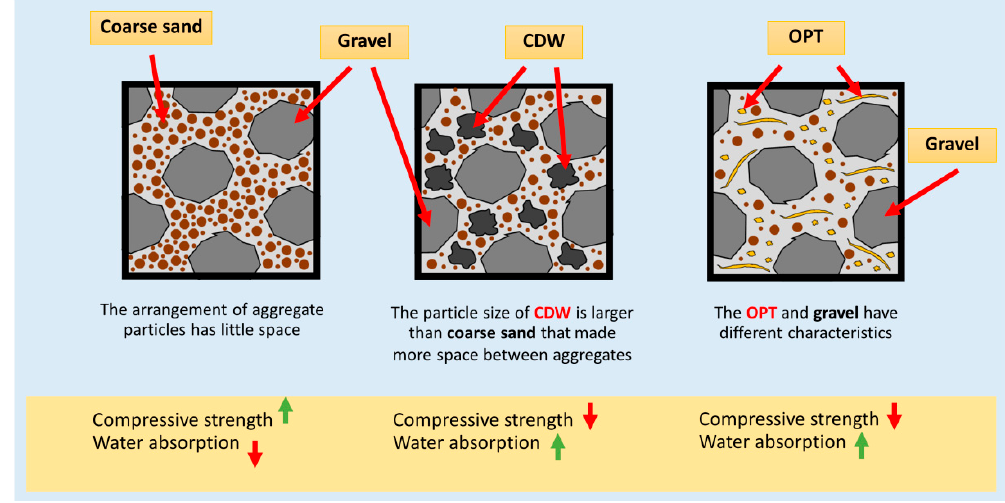
Figure 7. Cross sections of concrete brick specimens.